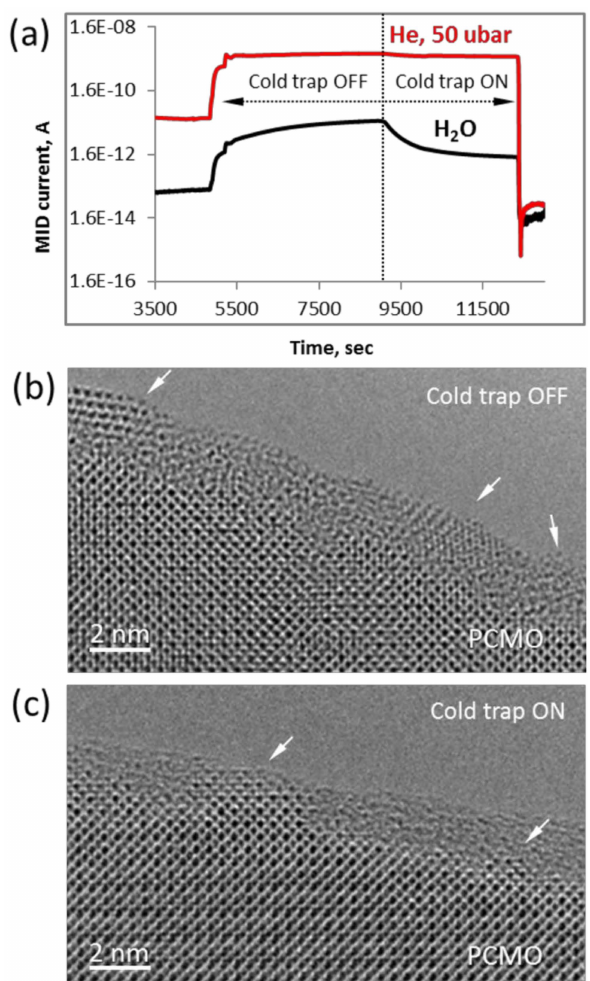
Figure 9. ( a ) A snapshot of Quadera ™ software during environmental transmission electron microscopy (ETEM) experiment at 50 ubars of He with and without activated cold trap. Experimental HRTEM images in He when the cold trap was OFF and ON are shown in ( b ) and ( c ), respectively. The white arrows point out on randomly oriented PrO 2 particles, growing in amorphous layer ( b ), and epitaxially growing pyramids of PCMO (x = 0.33) ( c